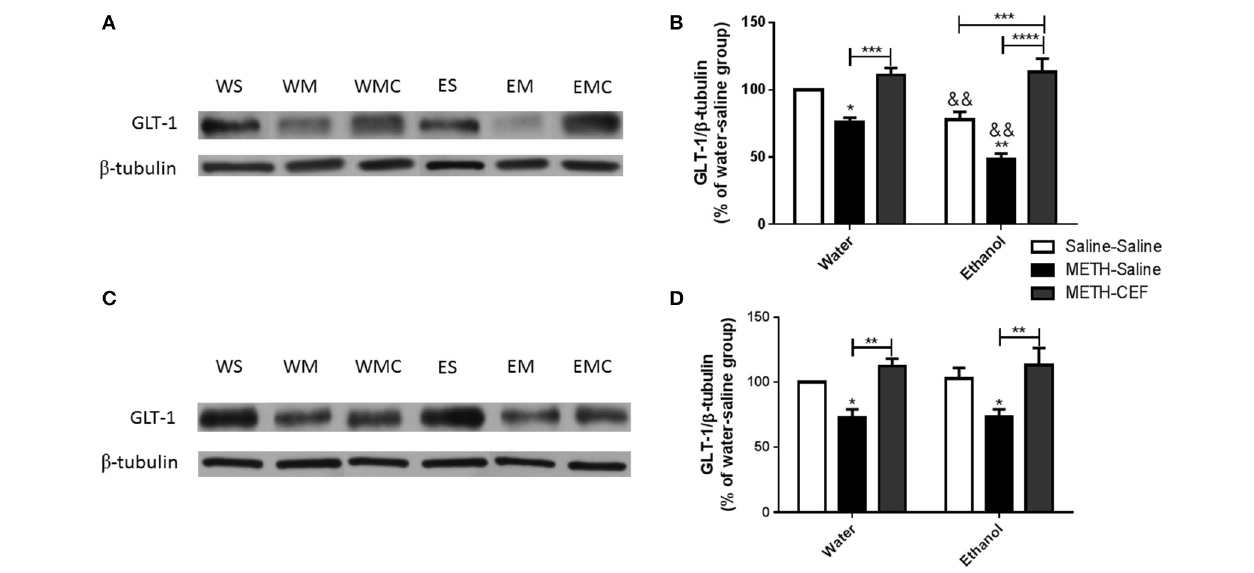
FIGURE 2 | Effects of METH (10 mg/kg i.p. every 2h × 4), ethanol and CEF (200mg/kg) on GLT-1 expression in the NAc and PFC. (A,C) Immunoblots for GLT-1 as well as β -tubulin, which was used as a control loading protein, in the NAc and PFC, respectively, as compared to water-pretreated groups and ethanol-pretreated groups. (B,D) Quantitative analysis revealed a significant increase in the ratio of GLT-1/ β -tubulin in METH-CEF-treated (WMC or EMC) rats compared to the METH-Saline-treated rats in the water (WM) and the ethanol (EM) groups, in the NAc and PFC, respectively. Significant downregulation of GLT-1 expression was revealed in the METH-Saline-treated groups compared to control in water- and ethanol-treated groups in the NAc and PFC. Significant downregulation of GLT-1 expression was revealed in ethanol-Saline-Saline (ES) and ethanol-METH-Saline (EM) groups compared to its corresponding water control groups in the NAc, but not in the PFC. No significant difference in GLT-1 expression was revealed in water-METH-CEF-treated (WMC) rats compared to water control groups. However, a significant increase in GLT-1 expression was found in the Ethanol-METH-CEF (EMC) group compared to ethanol control (ES) group in the NAc, but not in the PFC. * p < 0.05, ** p < 0.01 (or &&, for comparison between ethanol and its corresponding water control groups), *** p < 0.001, and **** p < 0.0001. Values shown as means ± S.E.M. n = 6 for each